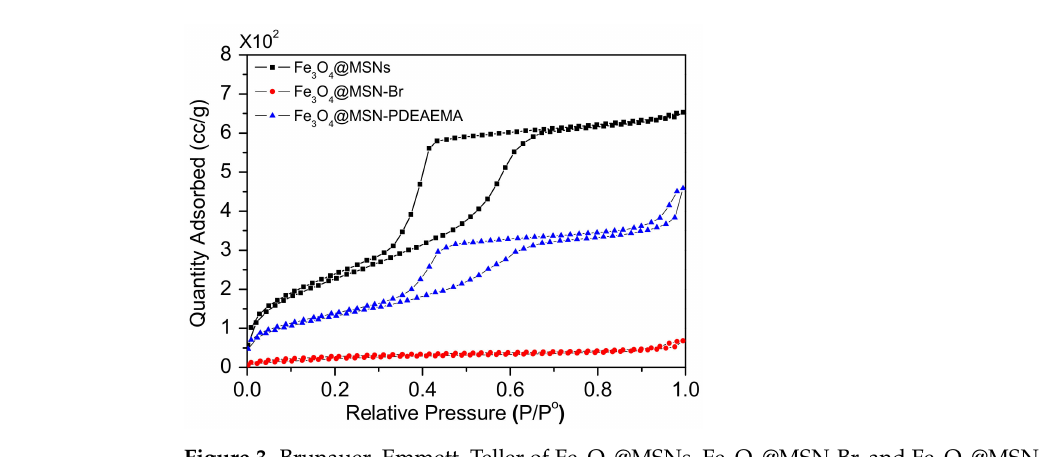
Figure 3. Brunauer–Emmett–Teller of Fe 3 O 4 @MSNs, Fe 3 O 4 @MSN-Br, and Fe 3 O 4 @MSN-PDEAEMA. FTIR spectra of Fe 3 O 4 @MSNs (with CTAB), Fe 3 O 4 @MSNs, Fe 3 O 4 @MSN-Br,